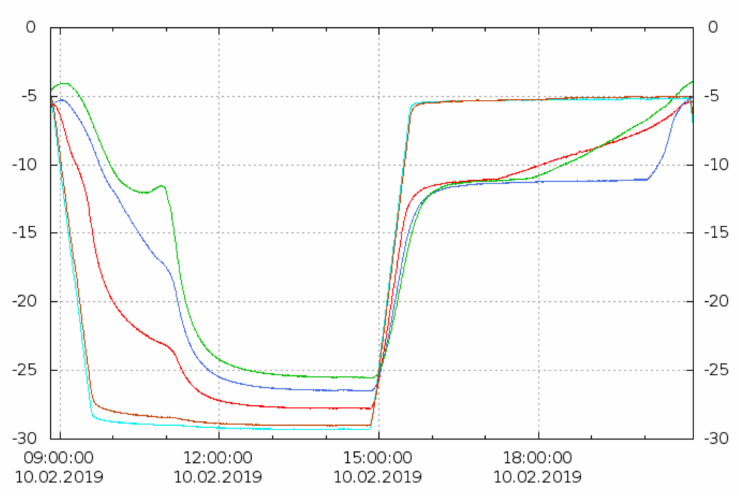
Figure 20. Temperature–time curves measured with the stability testing device “ZAE”.